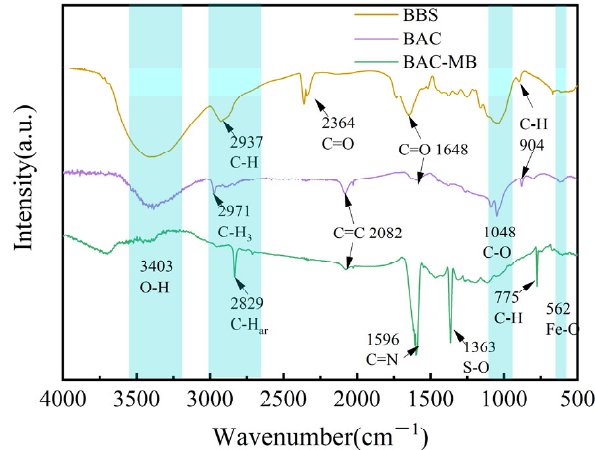
Figure 5. Surface functional groups of the BAC.